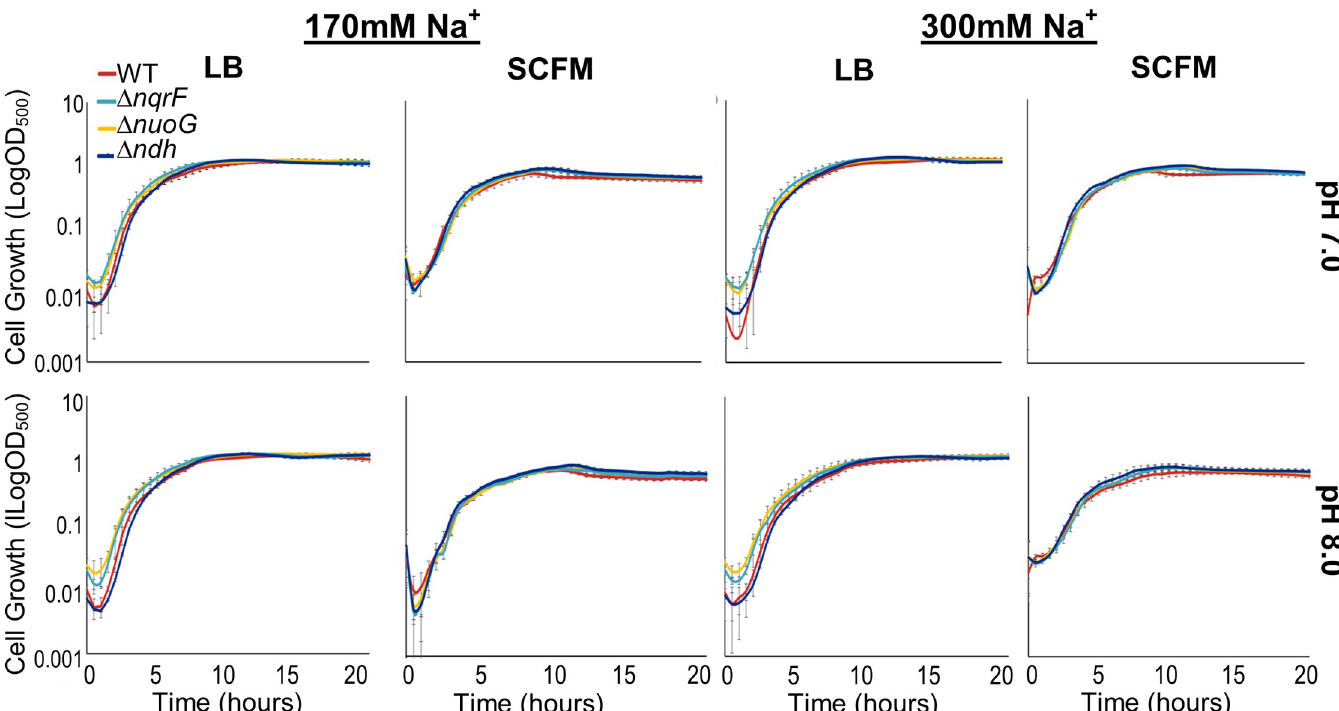
Fig 1. Comparison of growth of wild type and single deletion mutant strains. Growth curves of wild type PAO1 (red) and single deletion mutants Δ nqrF (cyan), Δ nuoG (yellow), and Δ ndh (dark blue) plotted in log 10 scale in LB and SCFM media at 170mM and 300mM NaCl concentrations, at pH 7.0 and 8.0. Changes in OD 500 were measured using a Tecan Infinite M1000 Pro plate reader during 20 hours of growth at 37˚C with continuous orbital shaking at 217 rpm. Each curve was constructed using two biological replicates with three technical replicates each, with standard deviation calculated accordingly and represented as error bars.